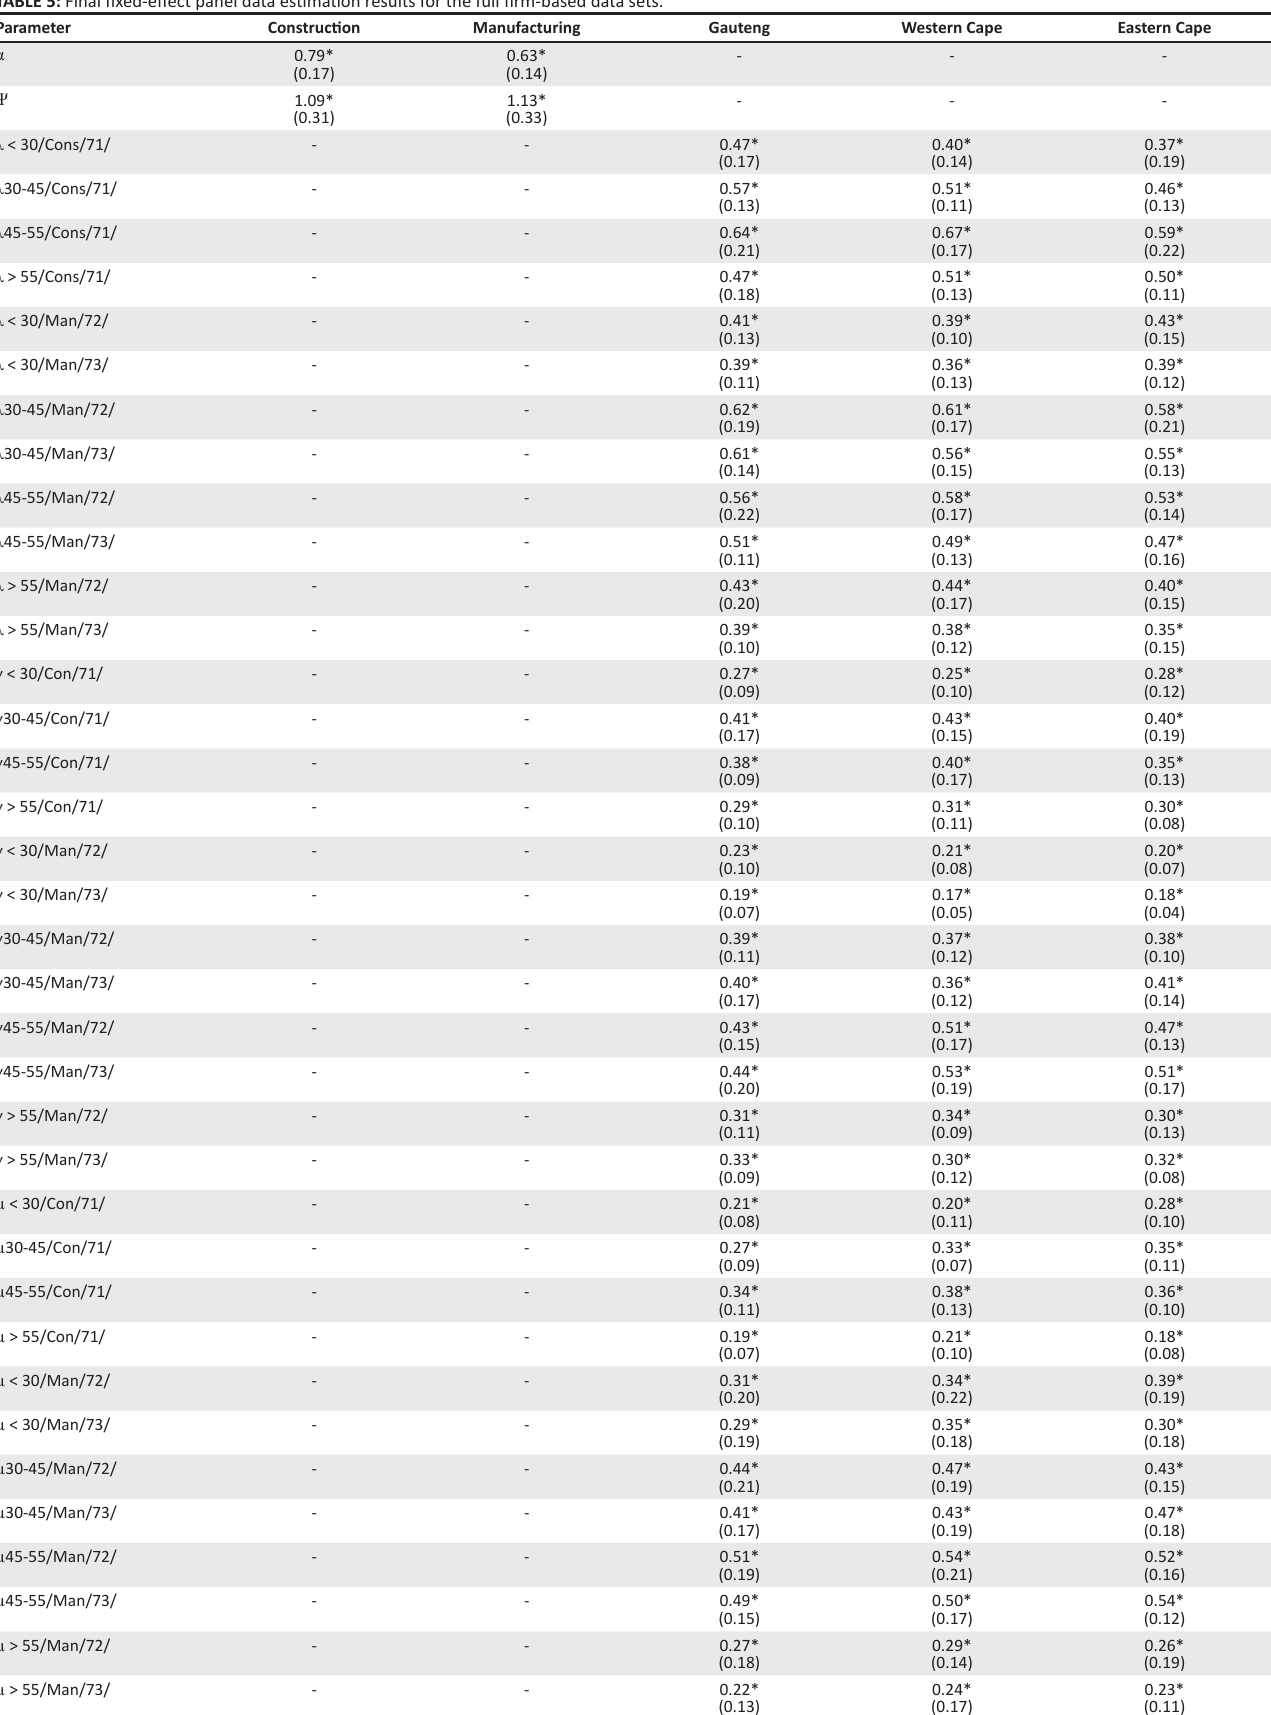
TABLE 5: Final fixed-effect panel data estimation results for the full firm-based data